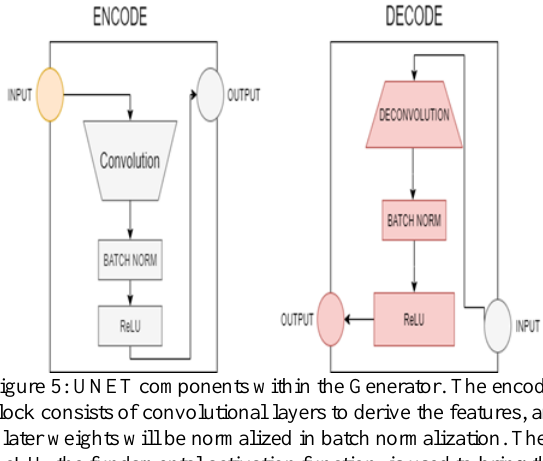
Figure 5: UNET components within the Generator. The encoder block consists of convolutional layers to derive the features, and later weights will be normalized in batch normalization. The ReLU, the fundamental activation function, is used to bring the Figure 3: Schematic of the Encoder-Decoder structure which non-linearity in feature extraction. The decoder block will maps an input image to latent space representation and back to a reverse the process in encoder block and receives the original reconstructed image. The red block will be the input image and data back from the encoded the CNN filters will derive more fine tunes features in hidden layers (GREEN and BLUE) and form a latent space representation.